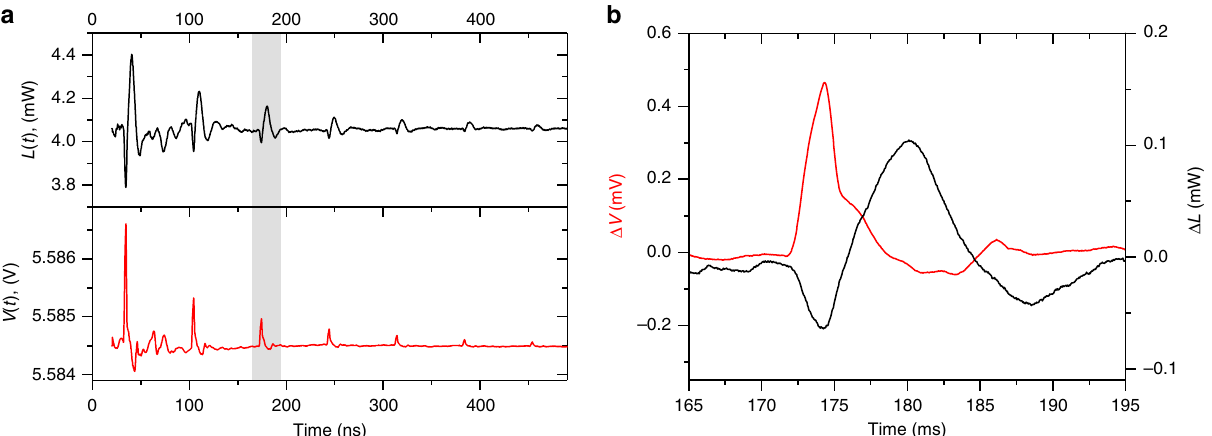
Fig. 2 Observation and measurement of the acoustic modulation on the QCL device. a Temporal response of the THz emission, L ( t ), (black trace, top) and QCL voltage, V ( t ), (red trace, bottom) to incident strain pulses generated with an optical pulse energy of 10 µ J at a QCL bias V b = V 3 . The initial strain pulse, arriving at time t = 32 ns, is generated by laser impact on the Al- fi lm transducer at t = 0 and the following pulses, occurring every 70 ns, are due to multiple re fl ections in the device. b Shows the change in the L ( t ) and V( t ) responses ( Δ L and Δ V , respectively) to an individual acoustic pulse for the region highlighted in ( a ). Data have been smoothed using a 20-point rolling average fi lter. Source data are provided as a Source Data fi le.